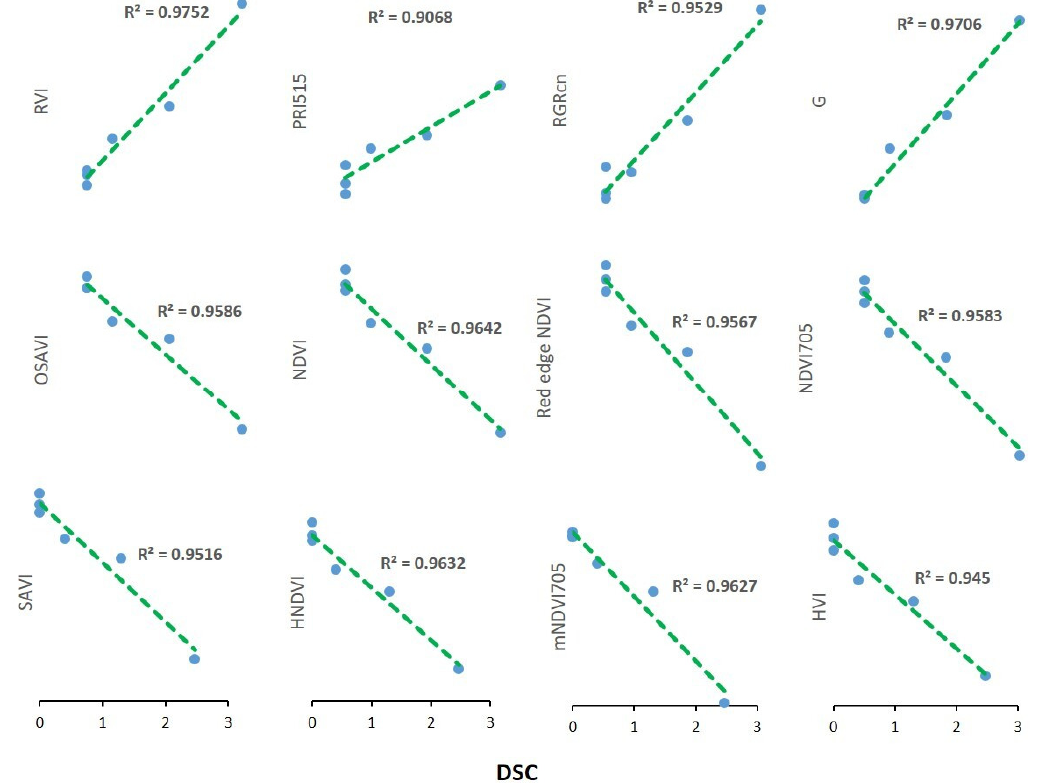
Figure 5. Pearson’s correlation of the hyperspectral vegetation indices highly correlated ( p -value ≤ 0.05 and R 2 > 0.9) with disease severity classes (DSC) exhibited by wild rocket infected with F. oxysporum f. sp. raphani .